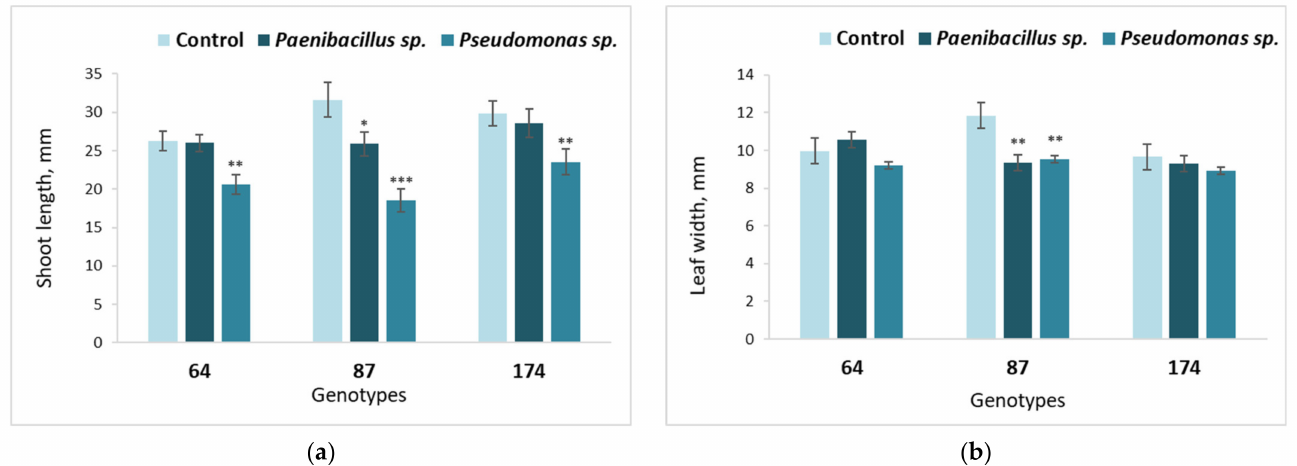
Figure 3. Average shoot length ( a ) and leaf width ( b ) of different ash genotypes (64, 87 and 174), inoculated with Paenibacillus sp. or Pseudomonas sp. bacteria. Statistically significant differences from the bacterium-free control variant are indicated (for each genotype separately): * p < 0.05; ** p < 0.01; *** p <